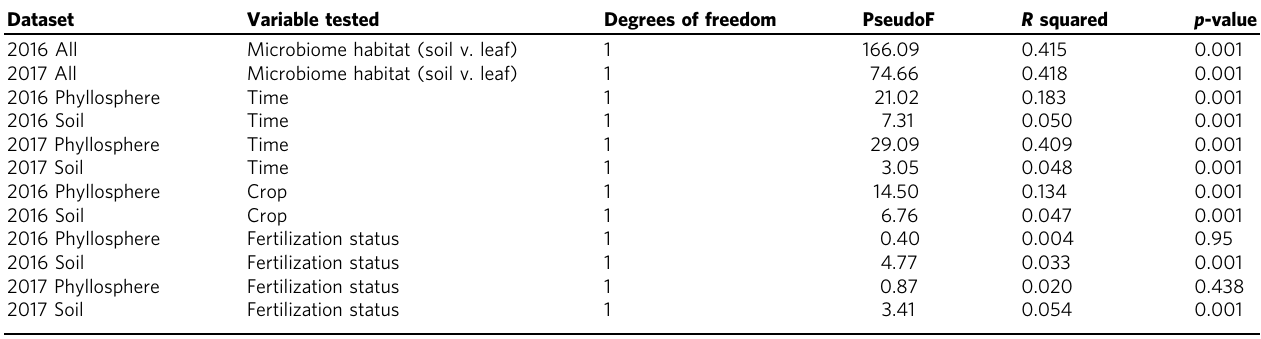
Fig. 2 Seasonal patterns in the structures of bacterial and archaeal communities inhabiting the phyllosphere and associated soils of the biofuel feedstocks switchgrass and miscanthus. a Principal coordinates analysis (PCoA) of switchgrass (light green circles, 2016 = fi lled and 2017 = open) and miscanthus phyllosphere communities (dark green circles, Bray-Curtis dissimilarity), error bars show 1 deviation around the centroid ( n = 1 to 8 replicate plots/time point; please see Supplementary Table 1 for exact replicates per time point). b PCoA of the phyllosphere communities (circles) relative to the soil (standard fertilization are squares and nitrogen free are diamonds). For both a and b , subsampling depth was 1000 reads per sample and environmental vectors were fi tted when r 2 > 0.4 and p < 0.05. For both panels, the size of the symbol re fl ects the sampling week in the season, with smaller symbols used for the earlier time points and larger symbols for the late time points Table 1 Permuted multivariate analysis of variance (PERMANOVA) tables for all hypothesis tests for differences in community structure (beta